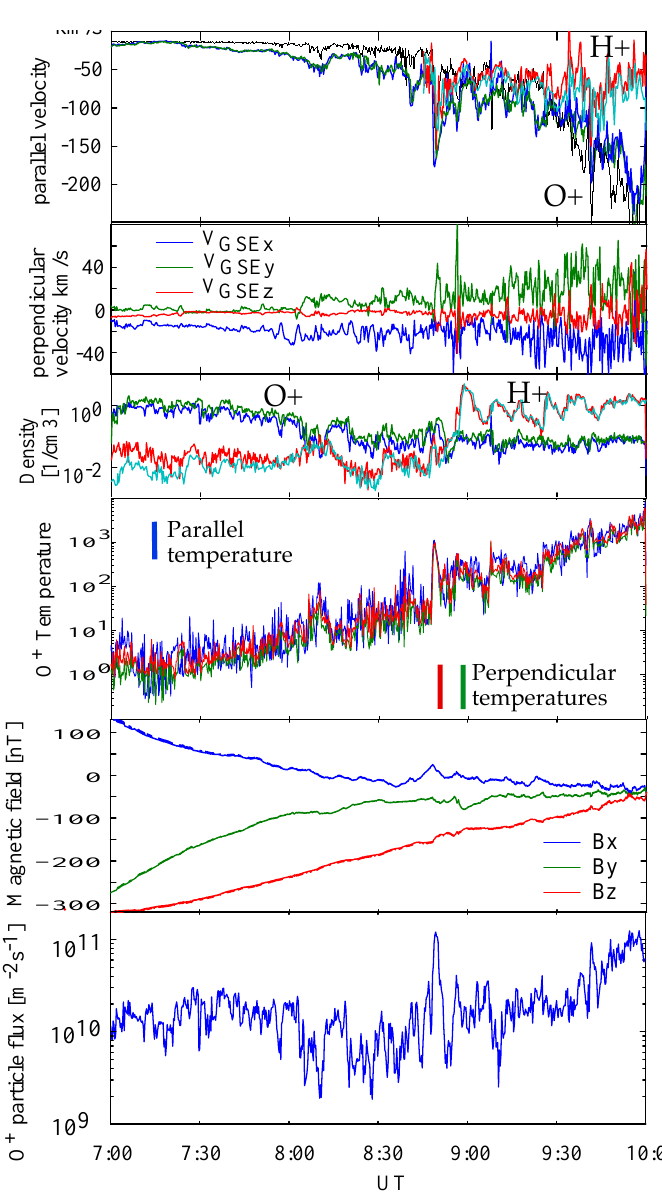
Fig. 4. Moment data for spacecraft 3 (unless otherwise mentioned). Panel 1 shows the field-aligned velocity (positive in the direction of B), where red and cyan show H + from spacecraft 3 and 4, respectively, and blue and green show O + for spacecraft 3 and 4. Also included is a simple estimate of the parallel velocity (thin black line, see text for details). Panel 2 shows the field-perpendicular velocity panel in GSE coordinates (blue, green, red are x, y, z coordinates, respectively), panel 3 the density (same colour code as parallel velocity), panel 4 the parallel and perpendicular temperatures for O + , panel 5 the magnetic field components and panel 6 the O + number flux normed with the magnetic field strength at 07:00